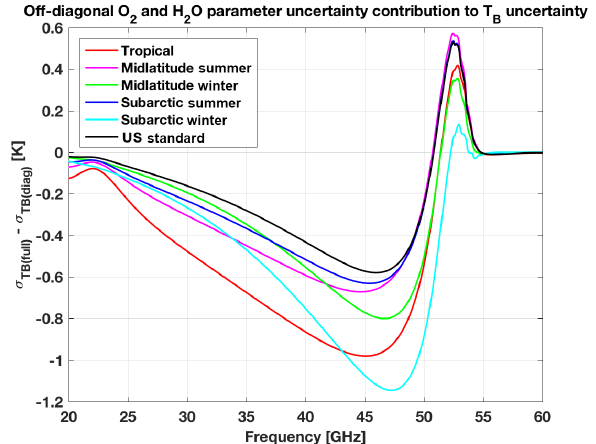
Figure 8. Difference between σ ( T B ) as computed considering the full uncertainty covariance matrix and its diagonal matrix (i.e., off- diagonal terms are set to